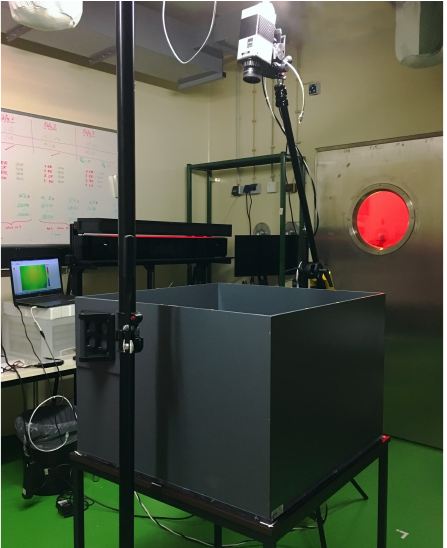
Figure 3. Photo of the setup used for the OFTs in